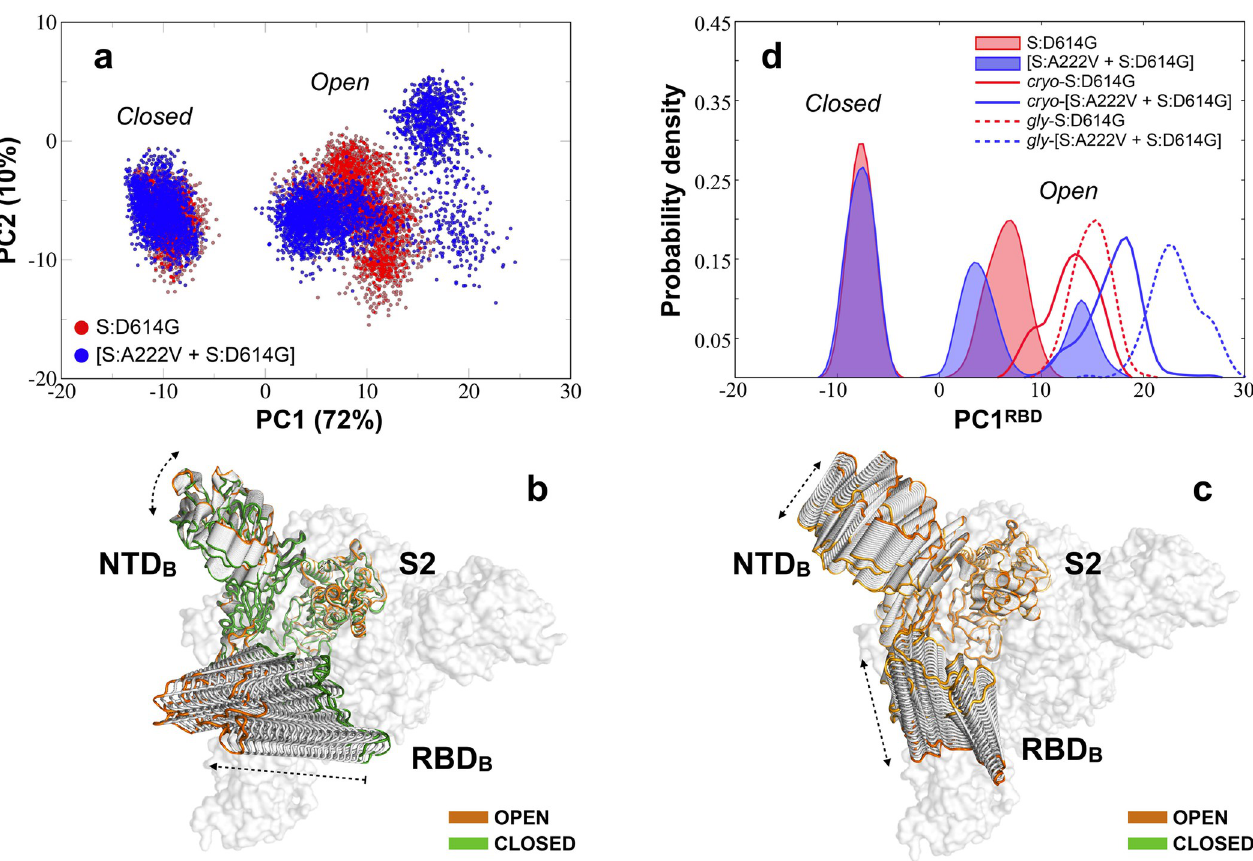
Fig 6. PCA for the three MD simulated systems. ( a ) PCA projection of the first two high-variance motions for the S:D614G (in red) and [S:A222V + S: D614G] (in blue) mutants of SARS-CoV-2 S1 subunit of the glycan-free spike protein. ( b) Conformational evolution of the NTD and RBD along the first eigenvector (PC1) mainly accounting for the RBD closed-to-open transition. The open and closed states at the two ends of the PC1 are highlighted in orange and green, respectively. ( c ) Conformational evolution of the NTD and RBD along the second eigenvector (PC2) accounting for lateral RBD+NTD fluctuations. An orange gradient is applied here to distinguish between different lateral orientations of the open NTD-RBD pair at its two ends. ( d ) Continuous population densities along the PC1 for a PCA relative to the RBD (residues 330–530; PC1 RBD ): solid profiles are used for the simulated closed, 3-down and open, 1-up states from the glycan-free systems based on 6VXX and 6VSB while continuous and dashed lines are used to define population densities for the simulated open 1-up states of the cryo-EM and fully-glycosylated S:D614G (red) and [S:A222V + S:D614G] (blue)